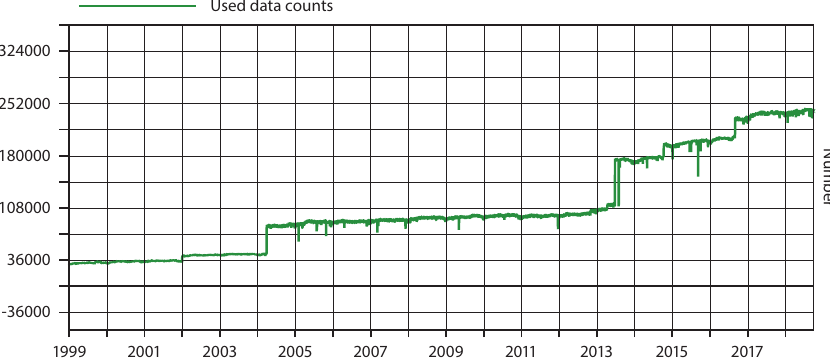
Figure 4. Number of available observations per unit area of 1 ◦ × 1 ◦ from the SYNOP and METAR networks in January, February and March 2018 for 2 m temperature ( upper ) and snow depth ( lower ).